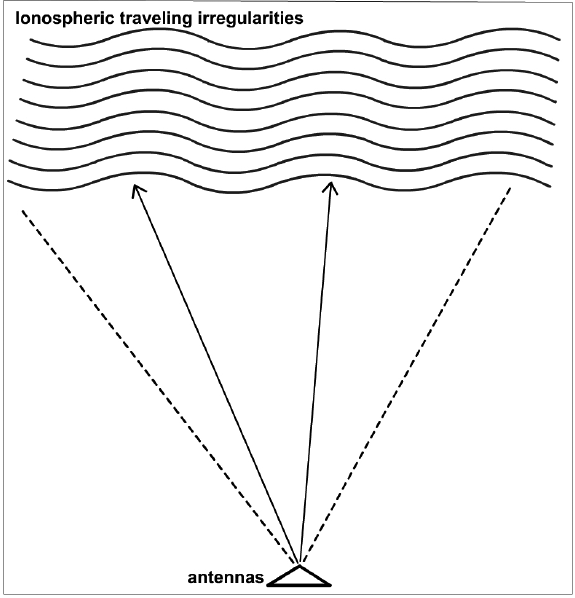
Figure 3. Multi-reflectors produced by traveling irregularities. Sig- nals off vertical represented by dashed line are filtered out by the range gating threshold of the receiver.